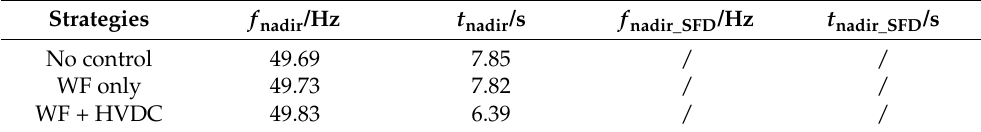
Figure 16. Active power and rotor speed of WTs in each subarea. ( a ) Active power of WTs in R1, ( b ) rotor speed of WTs in R1, ( c ) active power of WTs in R2, ( d ) rotor speed of WTs in R2, ( e ) active power of WTs in R3, and ( f ) rotor speed of WTs in R3. Table 6. Simulation results under low wind power permeability and low wind speed condition.